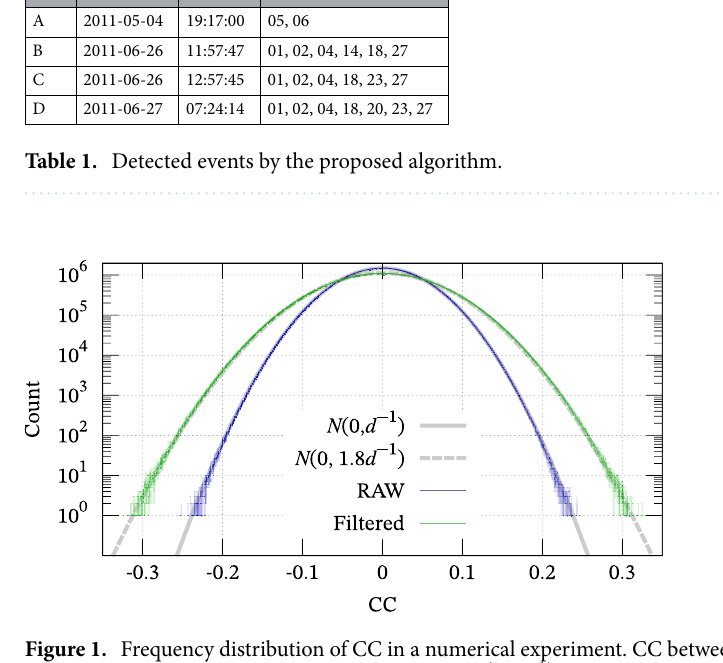
Figure 1. Frequency distribution of CC in a numerical experiment. CC between a raw random noise and a random template follows the normal distribution N